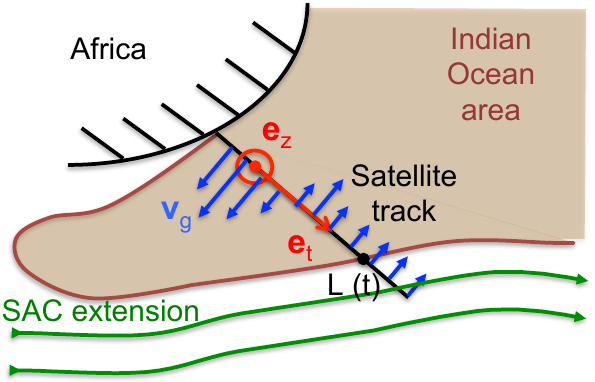
Figure 2. Schematic of vectors used for computation and variable L separating the Indian Ocean area from the extension of the South Atlantic Current